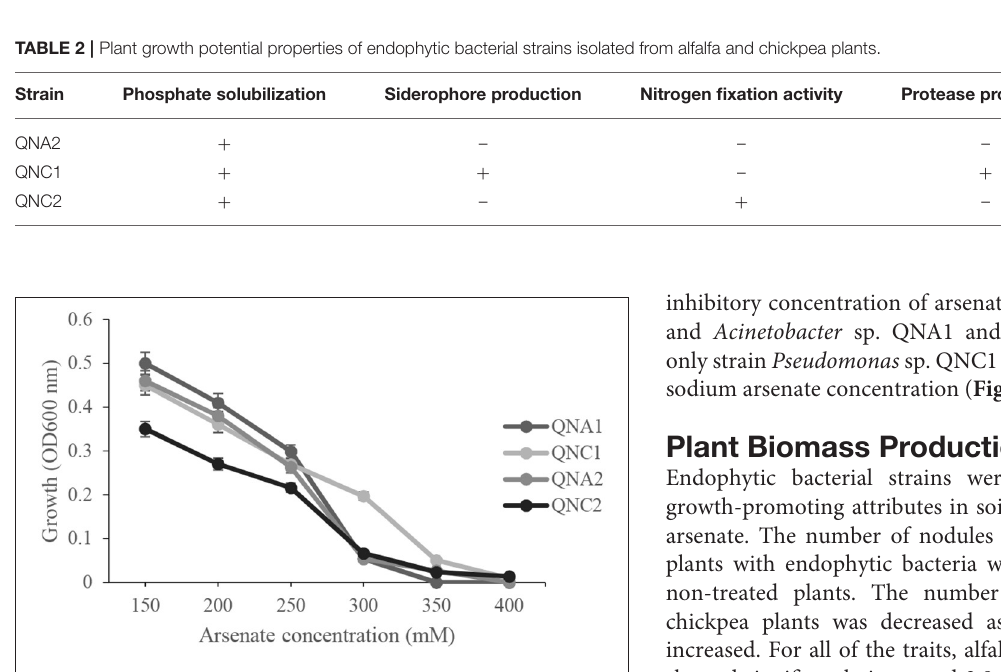
FIGURE 2 | Effect of different concentrations of sodium arsenate on the growth of Pseudomonas sp. QNC1, Rahnella sp. QNC2, Acinetobacter sp. QNA1 and Acinetobacter sp.